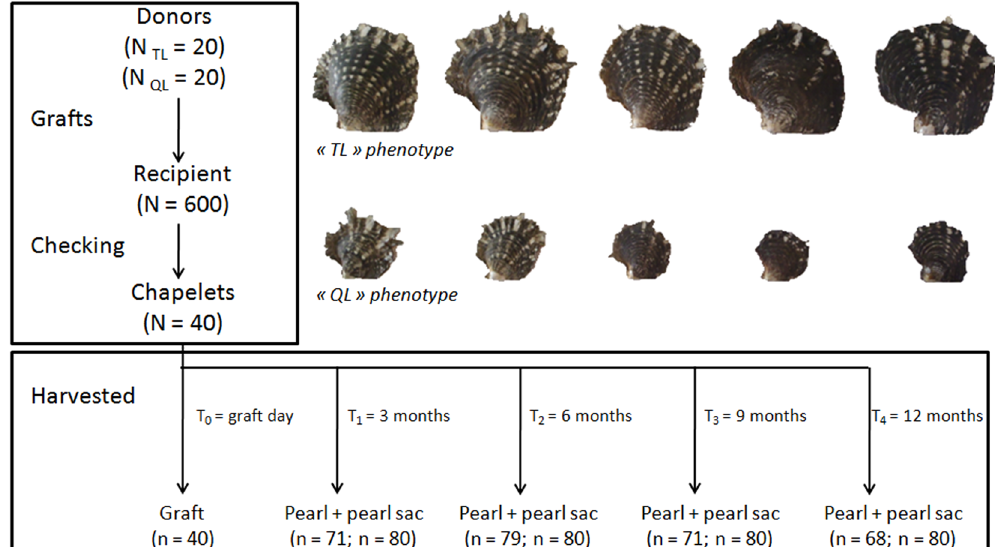
Figure 6. Experimental graft design for P. margaritifera donors using QL and TL phenotypes as donors. The grafts (N = 600) were performed on Regahiga Pearl farm (Mangareva Island, Gambier archipelago) then nucleus rejection and receiver mortality were evaluated 45 days after the graft operation (checking). Two recipient oysters per donor were randomly harvested every three months of the